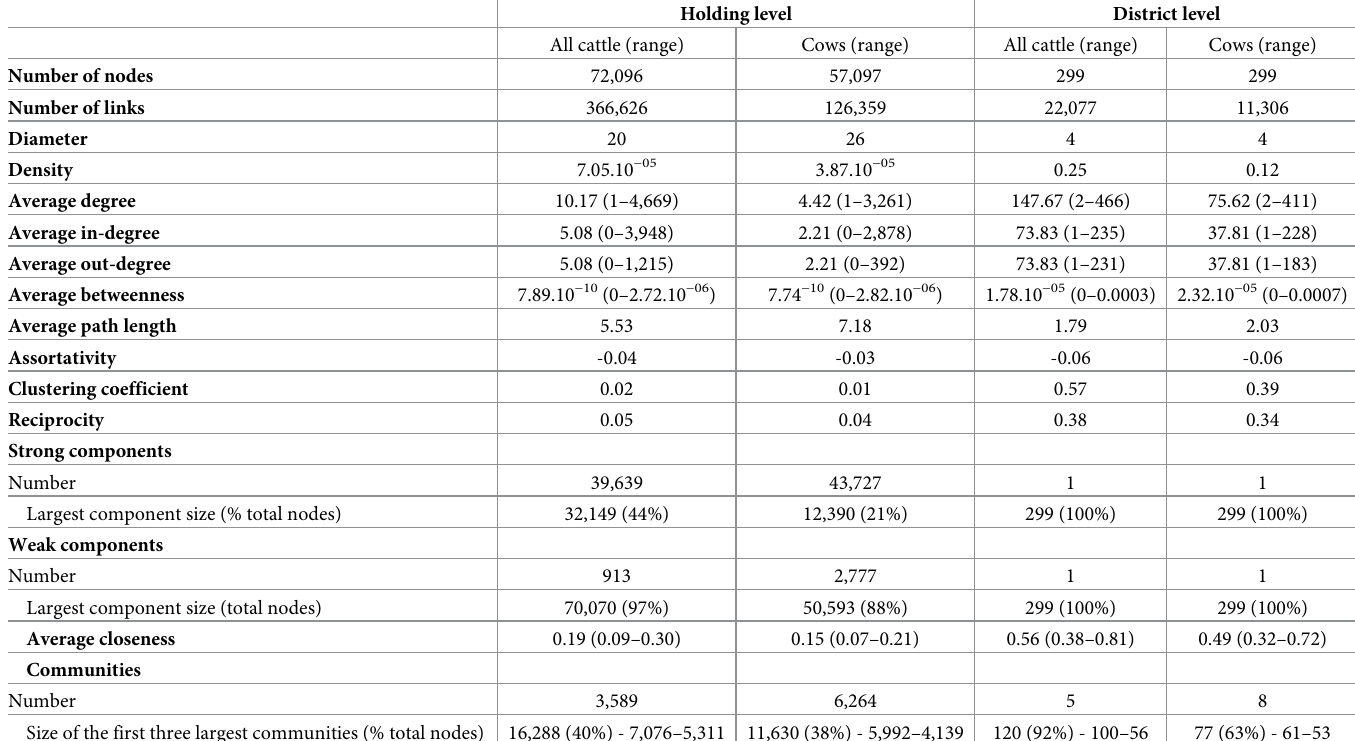
Table 4. Indicators for the global networks for all cattle and cows in Paraguay. Nodes and links were aggregated from 2014 to